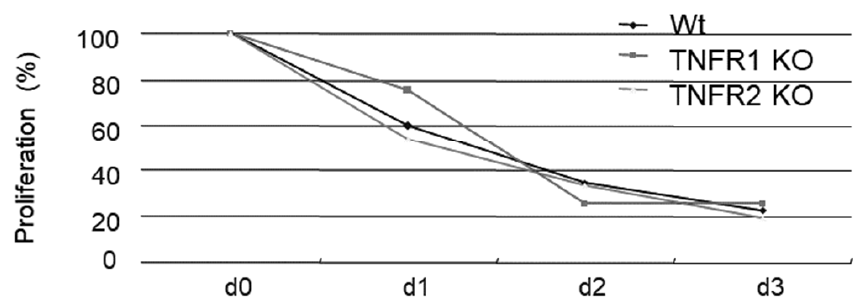
Figure 3. Macrophages from wild mice (C57BL/6), TNFR1-KO, or TNFR2-KO mice were infected with M. avium at an moi of 10. At days 1, 2, and 3, bacterial growth was counted. Bacterial growth is shown as a log scale compared with day 0. Each group consisted of five mice. There was no significant difference in bacterial growth between